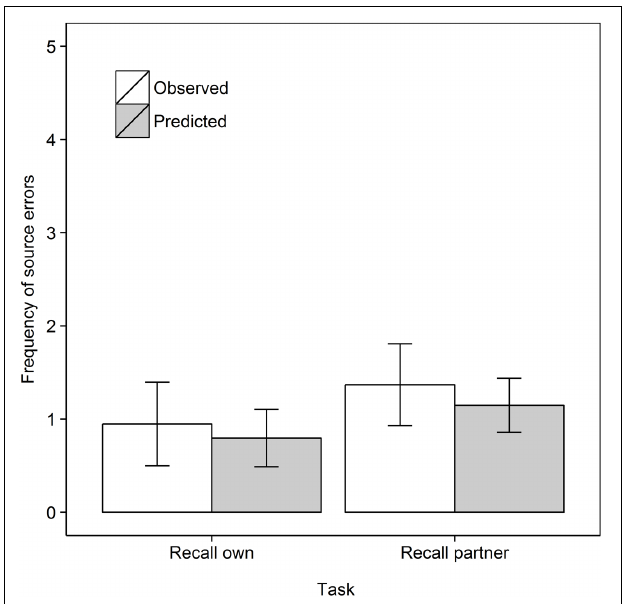
FIGURE 6 | Frequency of observed and predicted source errors in the Recall own task in Experiment 3 for all concurrent load conditions. The error bars are 95% within-subjects confidence